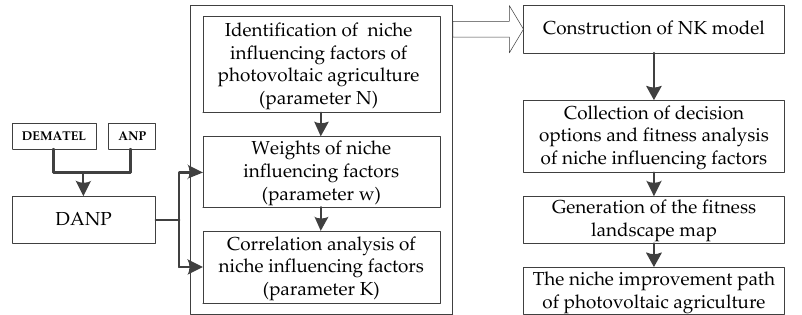
Figure 1. Analytical framework.